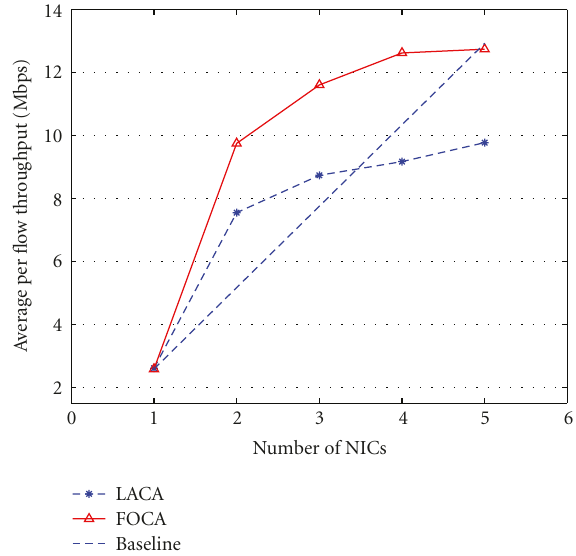
Figure 9: The impact of number of NICs when there are 6 available channels and three 5-hop